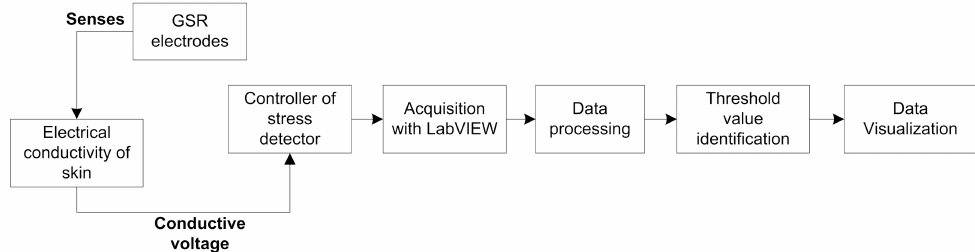
Figure 2. System